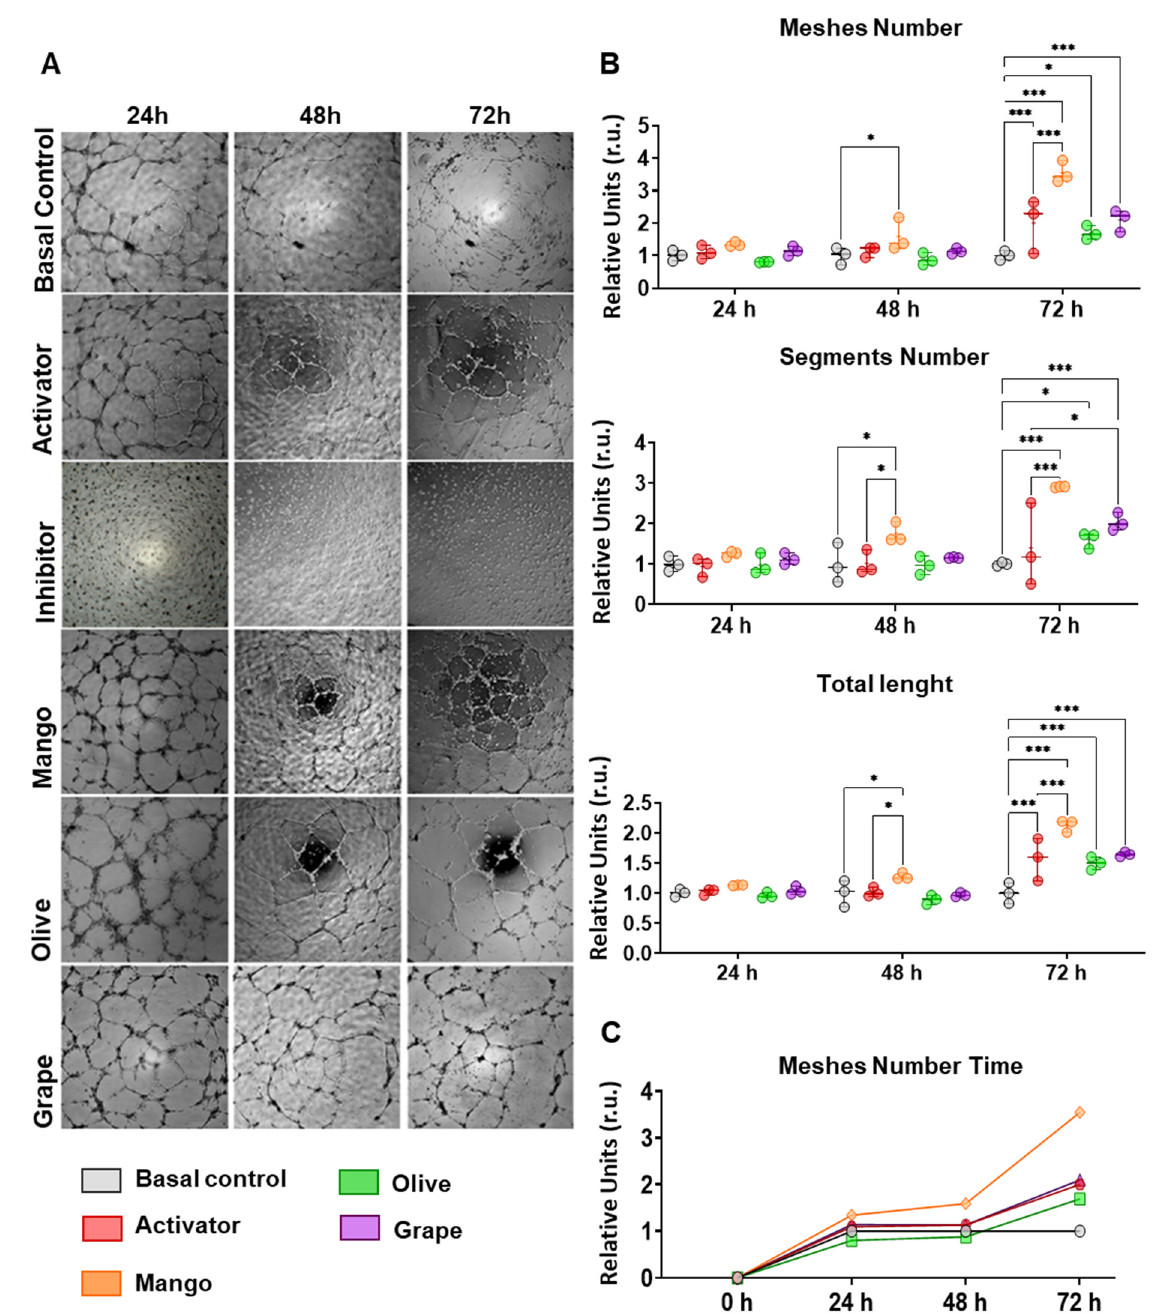
Figure 2. Effect of selected extracts on the angiogenic process of ECFCs. ( A ) Representative images of the reticular structures formed by ECFCs after 24, 48 and 72 h incubation in basal medium, with the inhibitor sulforaphane (15 mM), the activator FGF (35 ng/mL), or with mango (4.99 μ g/mL), olive (46.67 μ g/mL), and grape (16.67 μ g/mL) ethanolic extracts. ( B ) Graphical representation of the changes seen for the number of meshes, number of segments, and total length of the segments analyzed in ECFCs treated with mango leaves, olive leaves, and red grape pomace ethanolic extracts after 24, 48, and 72 h. ( C ) Temporal evolution of the number of meshes in ECFCs treated with the selected extracts. * p < 0.05; *** p <